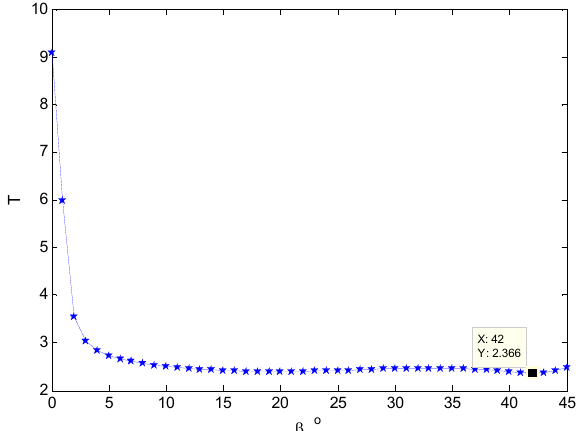
Figure 3: Relationship between scatter values T (19) and the angle β .